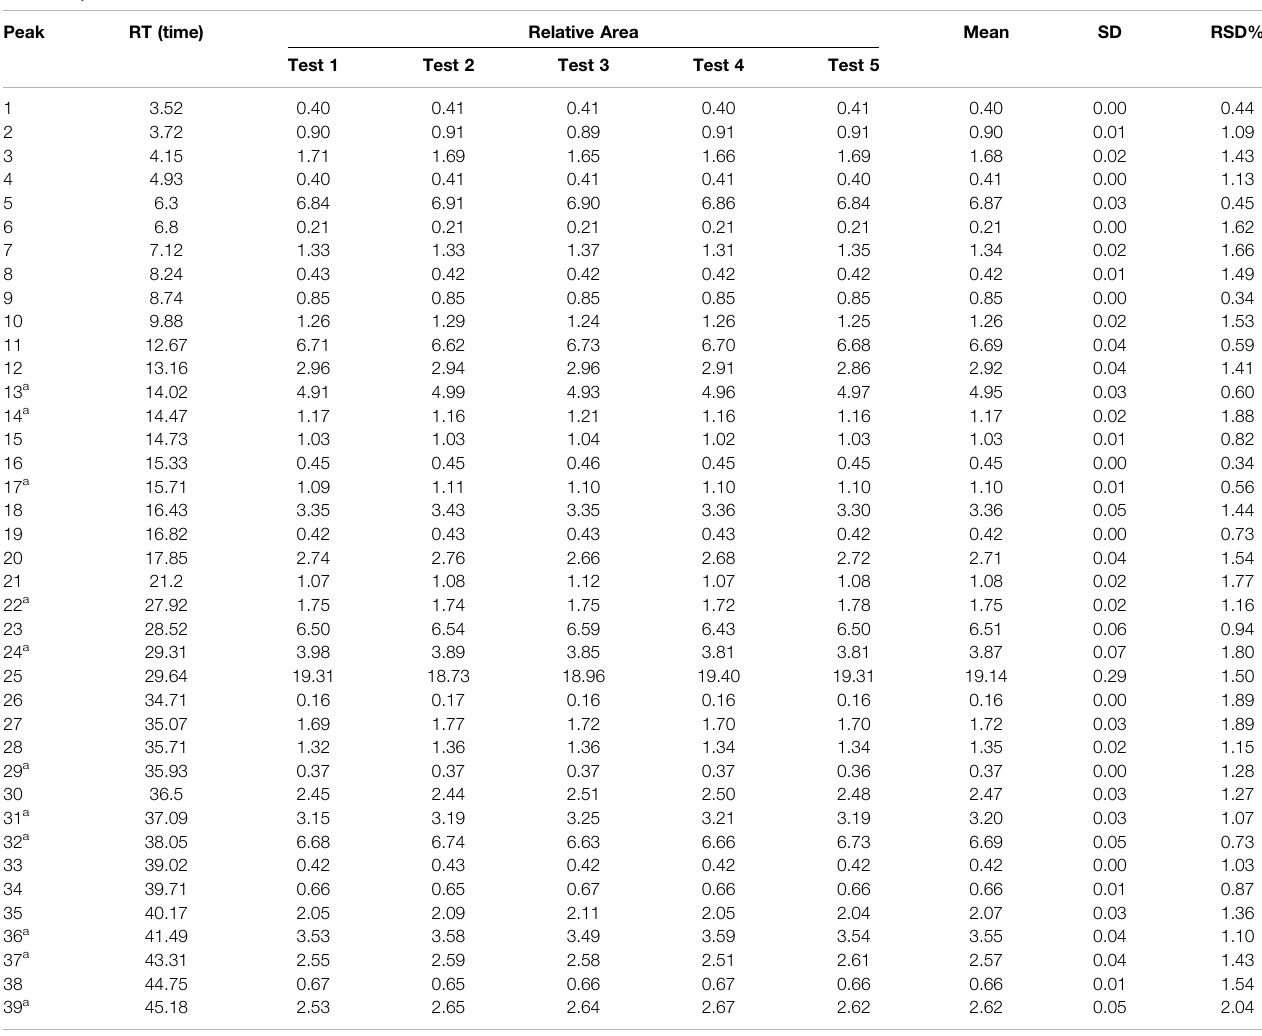
TABLE 3 | Precision test of relative area. Peak RT